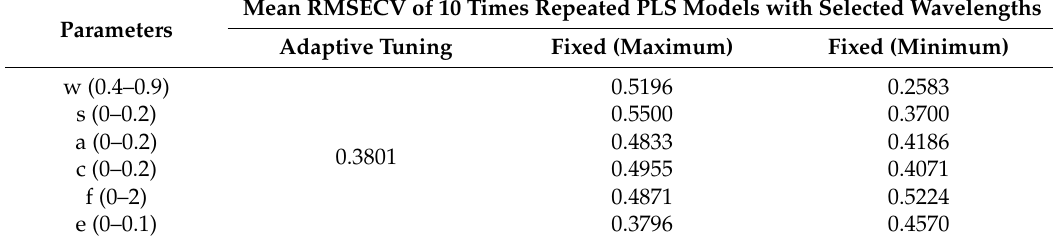
Table 3. The values of related parameters of BDA.